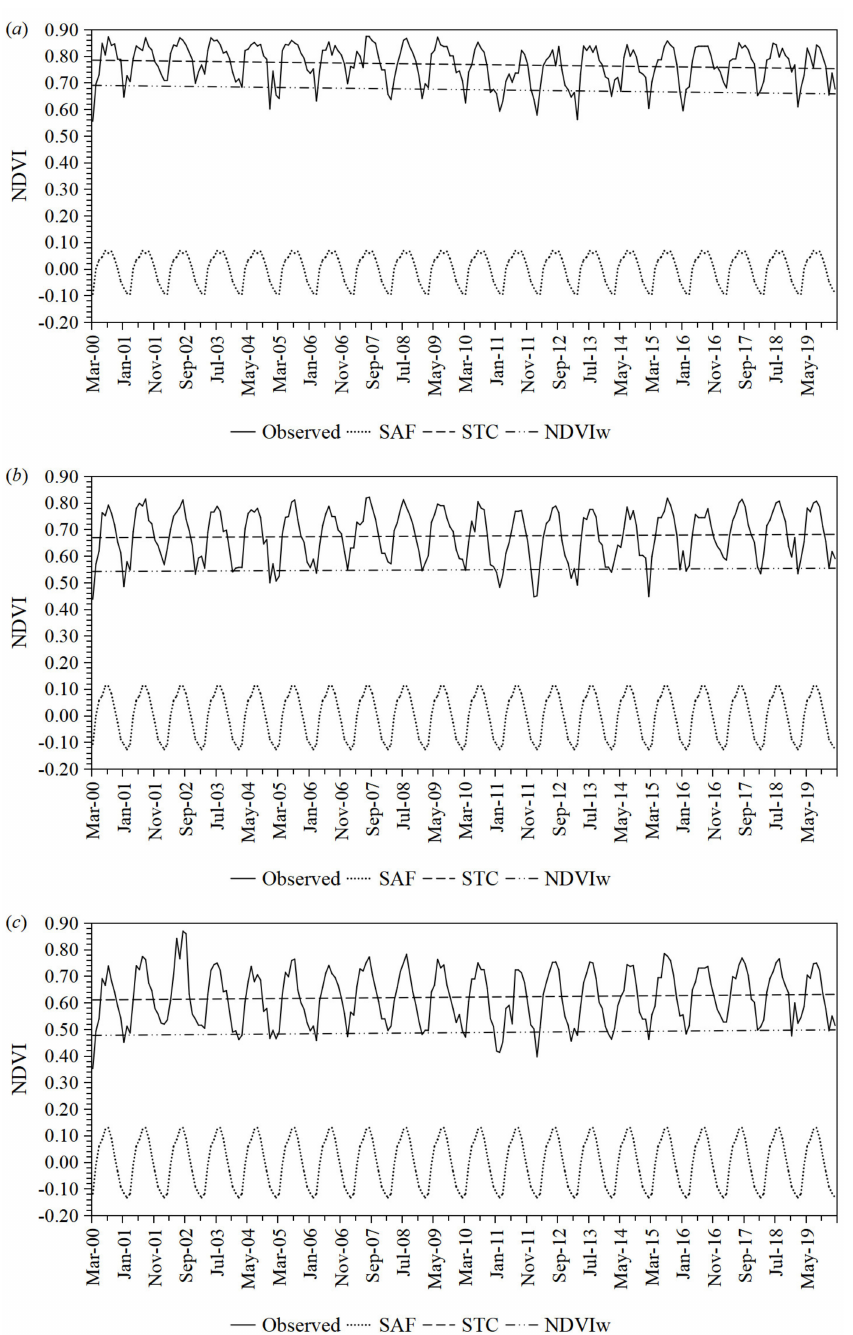
Figure 5. Decomposition results: ( a ) forests; ( b ) medium woodlands; and ( c ) sparse woodlands. Note: Here “Observed” denotes the original value of MODIS NDVI. X − axis represents months—240 in total; Mar − 00 = March 2000 and May − 19 = May 2019. SAF—seasonal factor sequence, STC—smooth trend cycle sequence, and NDVI W —woody component of the observed